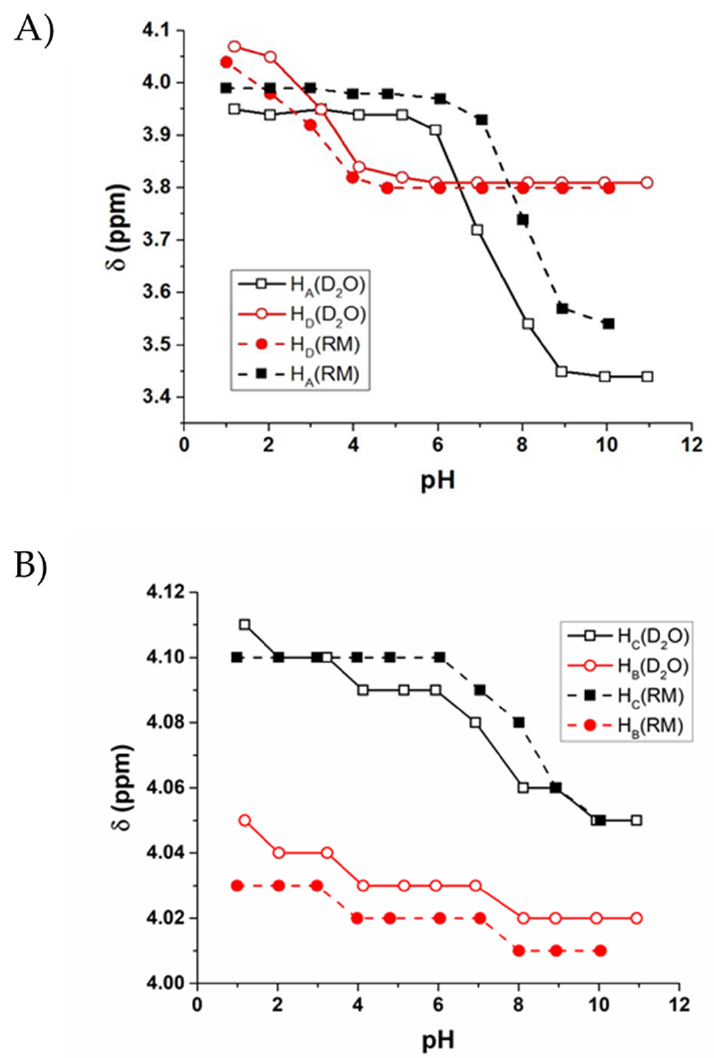
Figure 5. Chemical shift values as determined by 1 H NMR of GGGG at varying pH values in RM and D 2 O with peaks corresponding to labels in Figure 1D. RMs of size w 0 10 were formed with 200 mM GGGG in D 2 O. Error bars on graph are smaller than symbols used. ( A ) N- and C- terminal CH 2 protons of GGGG in D 2 O and RM, or protons A and D as labeled in Figure 1E. ( B ) Interior CH 2 protons on N- or C-terminal side of GGGG in D 2 O and RM, or protons B and C as labeled in Figure 1E.